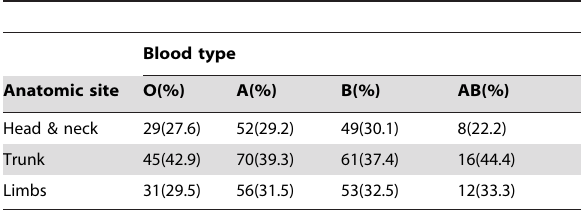
Table 3. Anatomic site of cutaneous malignant melanoma according to ABO blood type.